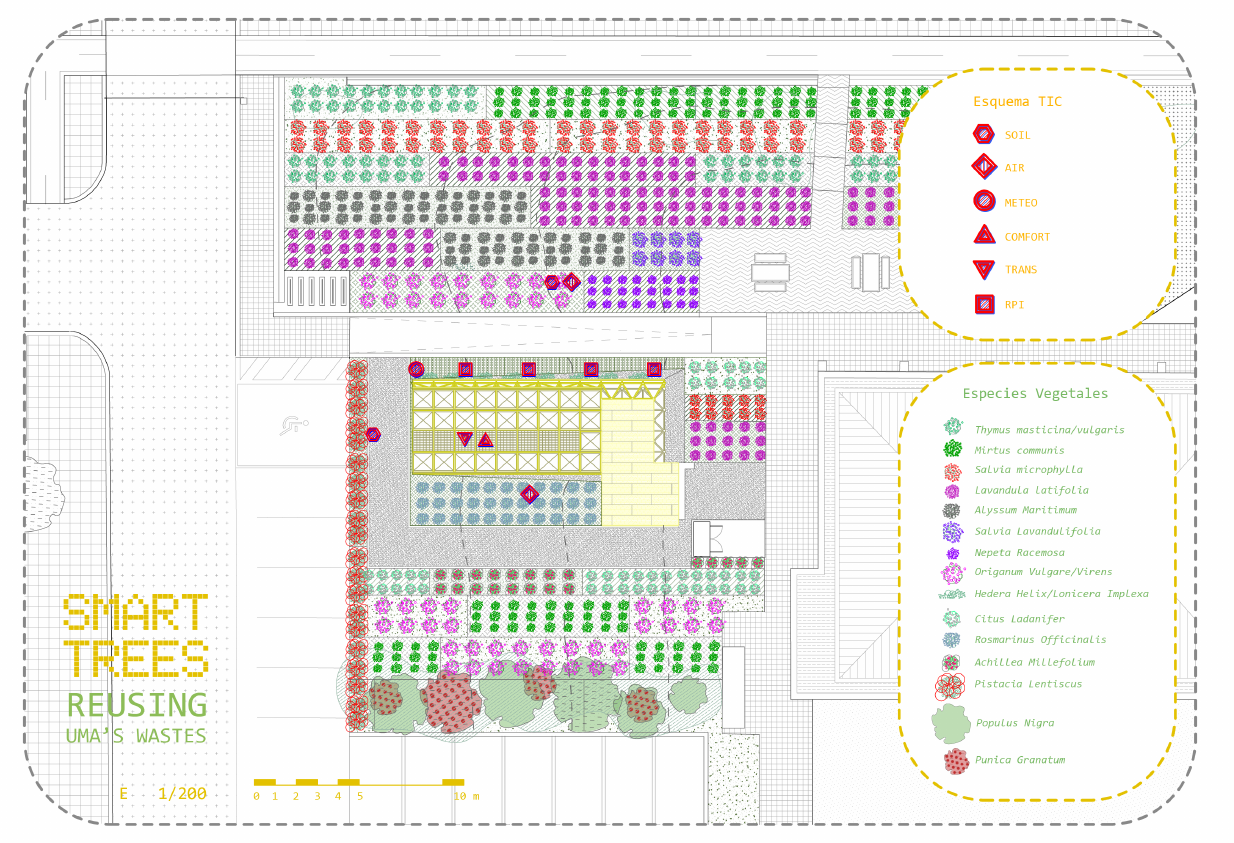
Figure 5. Situation map of the Smart Tree area, vegetation an location of the sensors and ICT